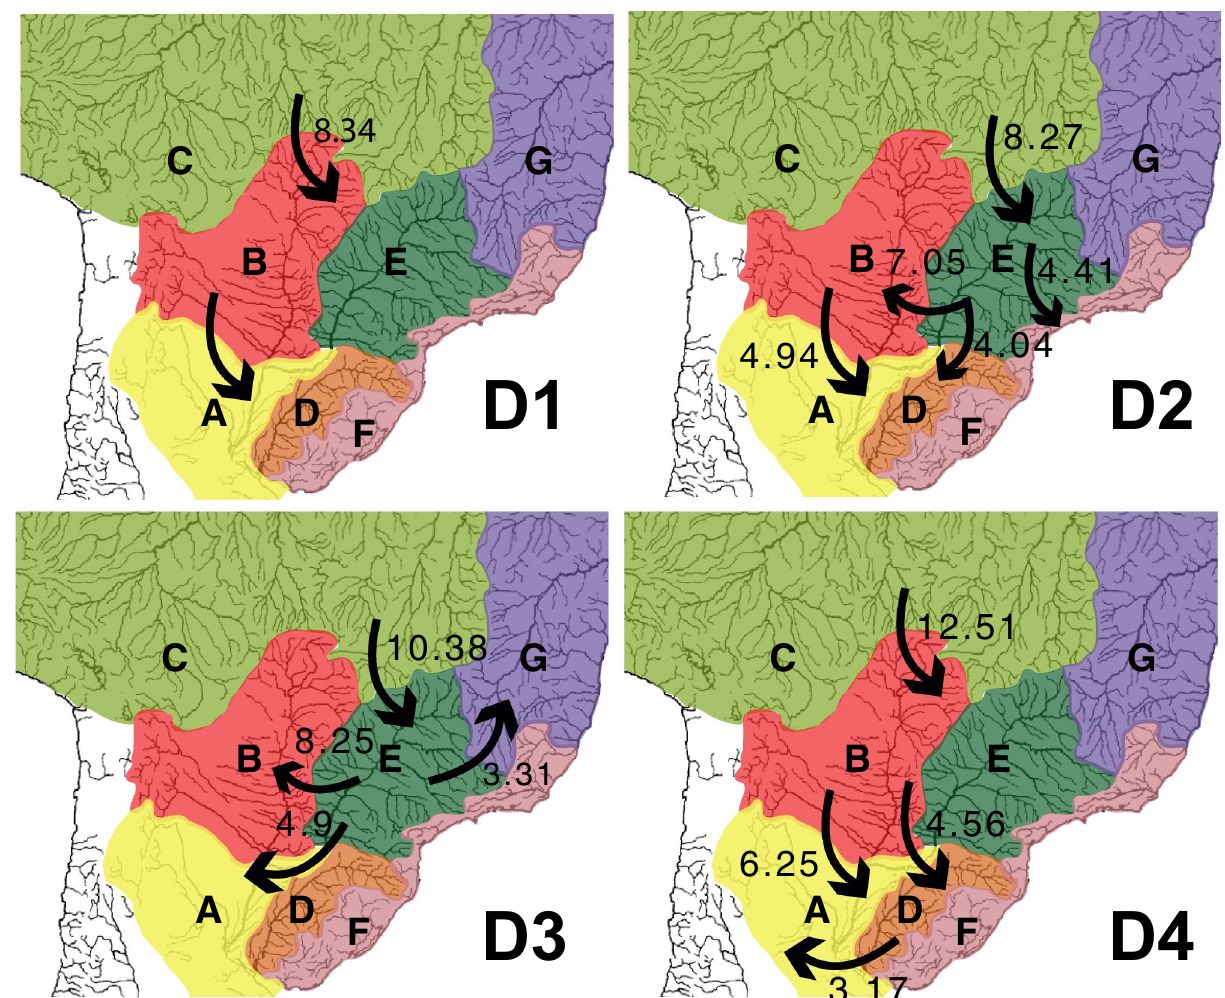
Figure 4. Graphic summary of the main colonizations in the evolutionary history of the genus Hypostomus in La Plata Basin. Major dispersals are shown with arrows. All dates representing the earliest possible time that the dispersal event could have happened and were taken from our time-calibrated tree (Fig. 1). Map was created in CorelDRAW Graphics Suite 2020 version 22.1.0.157 https ://www.corel